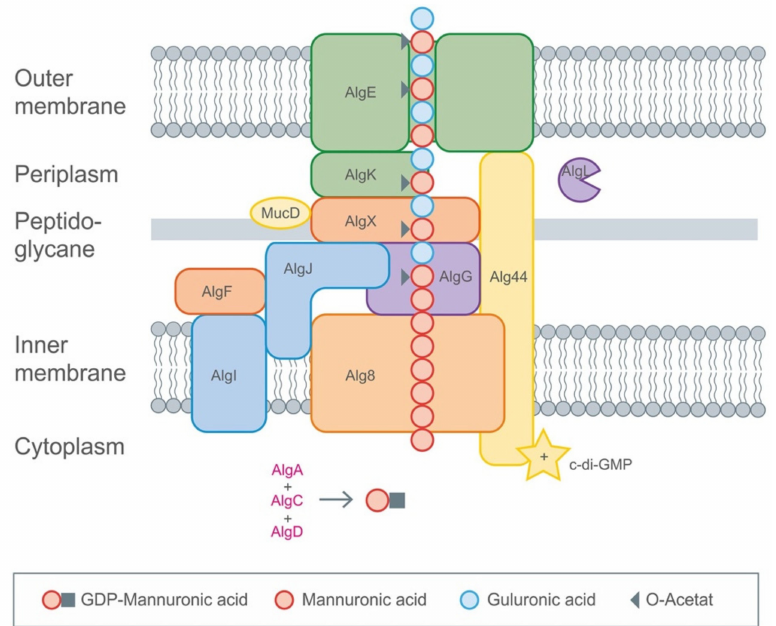
Figure 5. Schematic representation of biosynthesis of alginate in P. aeruginosa . Modified with permission from Schmid et al.